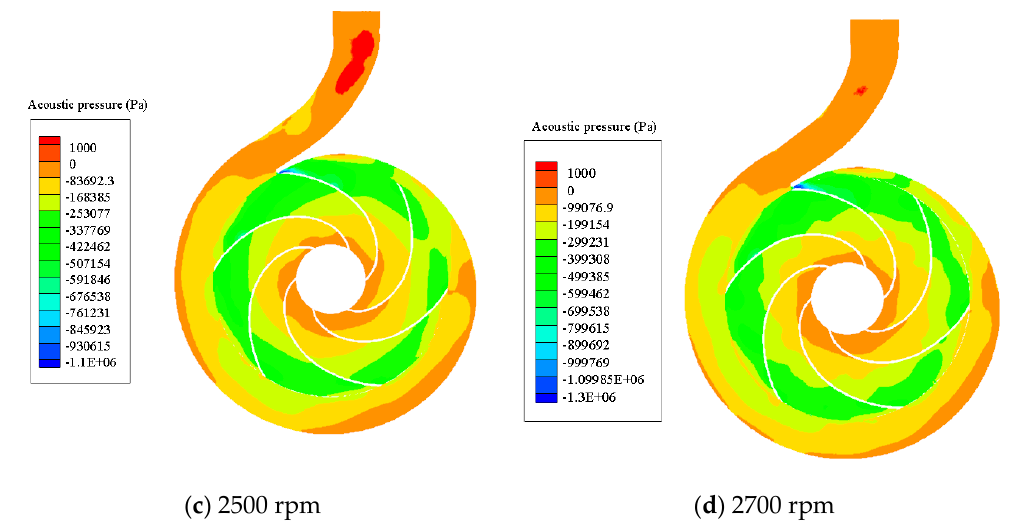
Figure 12. The distribution characteristics of acoustic pressure under various rotational speeds.